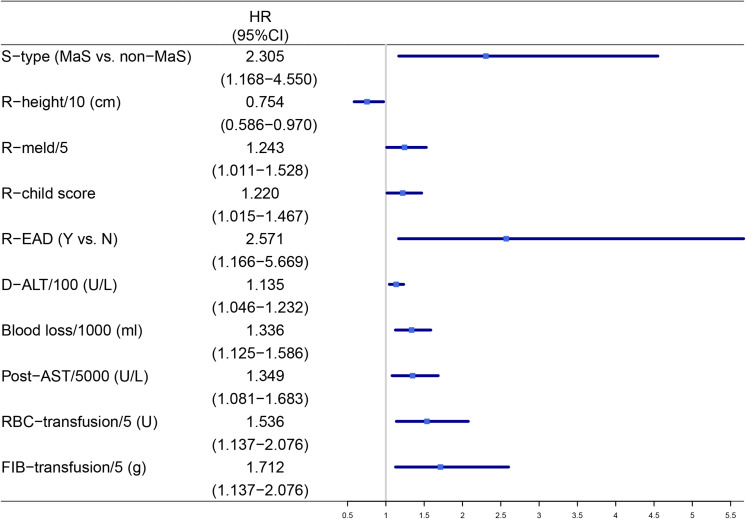
Factors significantly associated with post-transplant graft failures after multi-covariate analysis. AST, aspart aminotransferase; D, donor; EAD, early allograft dysfunction; FIB, fibrinogen; HR, hazard ratio; MaS, macrosteatosis; R, recipient; RBC, red blood cell; S, steatosis.